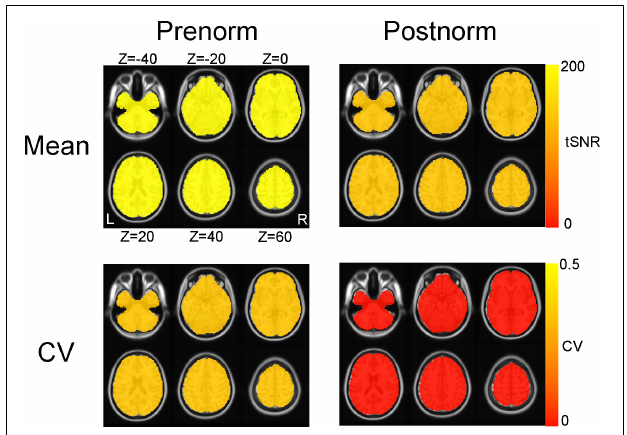
FIGURE 1 | Effect of normalization strategies on temporal signal-to-noise ratio (tSNR) of simulated images. The group mean maps of tSNR and coefficient of variation (CV) maps of tSNR were shown for both normalization strategies. Both mean and CV maps for Postnorm are constant maps. For Prenorm, both mean and CV of tSNR were larger than Postnorm condition and are not constant but very limited spatial variation (so seem like constant maps